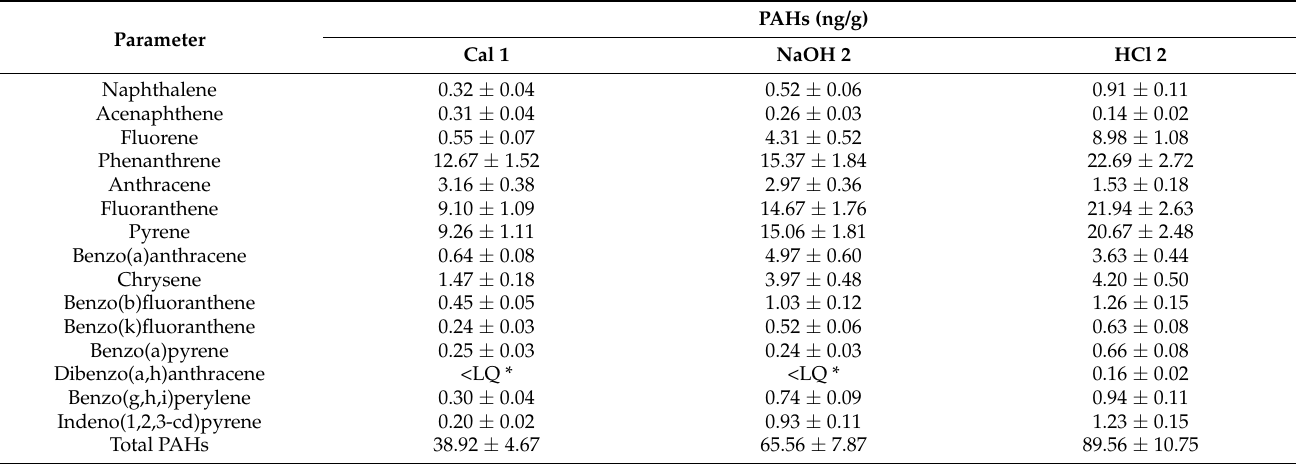
Table 10. Results for the degree of PAHs by zeolites